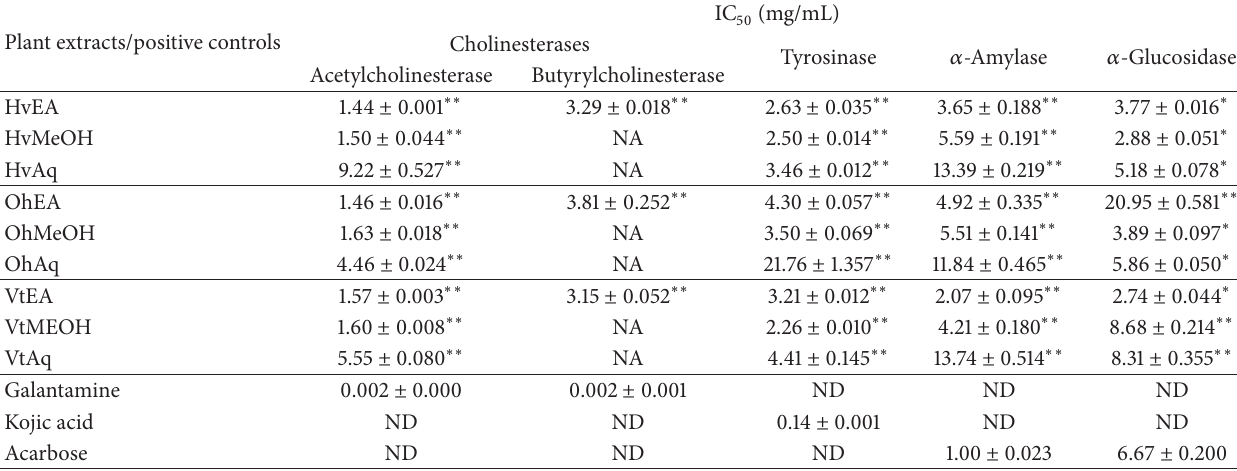
Table 3: Inhibition concentration of the plant extracts on cholinesterases, tyrosinase, 𝛼 -amylase, and 𝛼 -glucosidase. Plant extracts/positive